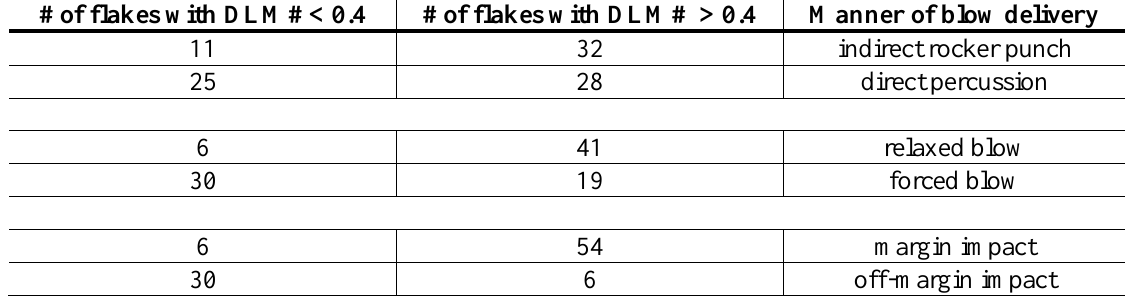
Table 1: Subjective data regarding the manner of blow delivery for each flake show that the mechanisms of fracture are greatly affected by how a knapper delivers a blow. # of flakes with DLM# < 0.4 # of flakes with DLM# >